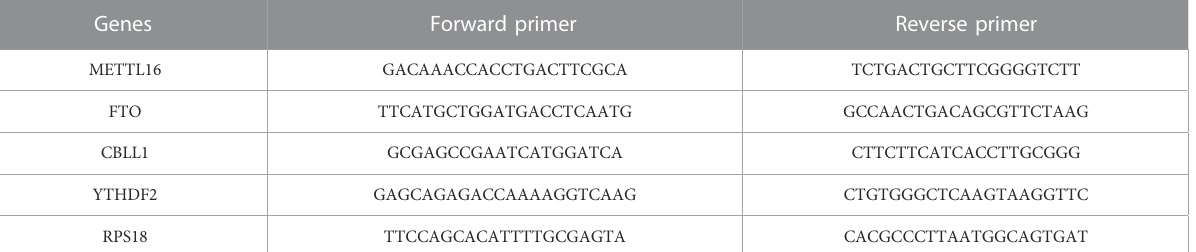
TABLE 2 Primer pairs used in the real-time PCR